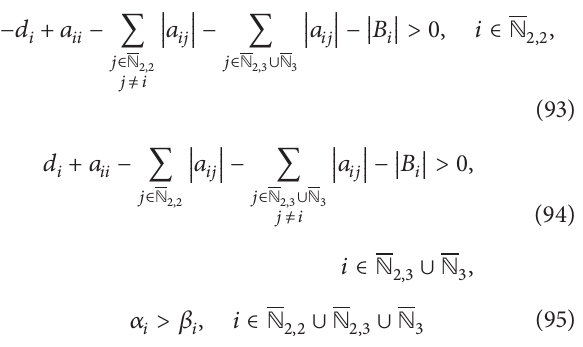
Figure 15: Phase plot of state variable (𝑥 1 ,𝑥 2 ,𝑆 1 ) 𝑇 in Example 2.